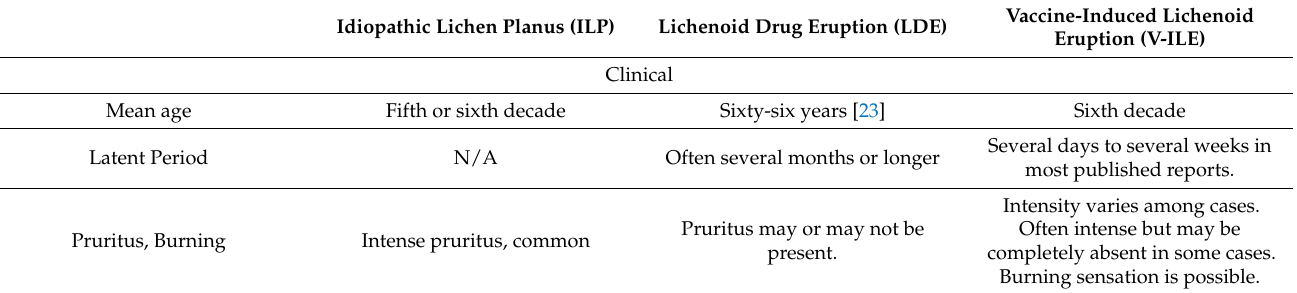
Table 4. Comparison of Clinical and Histopathologic Features of Idiopathic Lichen Planus (ILP), Lichenoid Drug Eruption (LDE) and Vaccine-Induced Lichenoid Eruption (V-ILE). Idiopathic Lichen Planus (ILP)